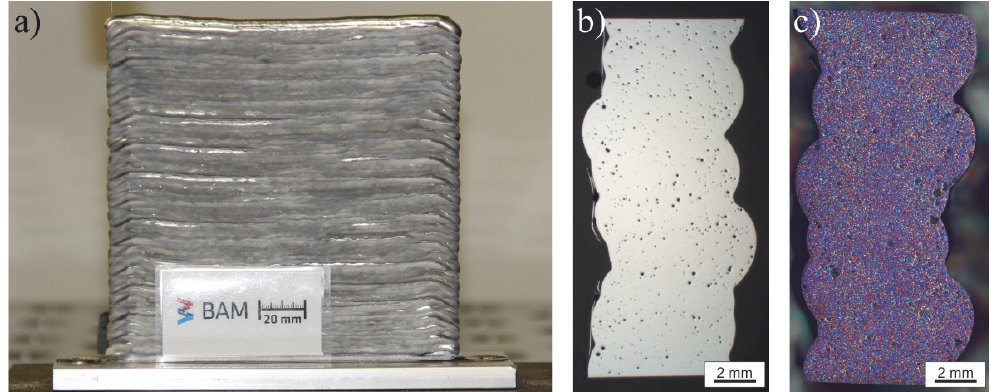
Figure 3. ( a ) WAAM wall made of S Al 6063-TiB, ( b ) unetched section H1 AW and ( c ) etched sec- tion M1 AW